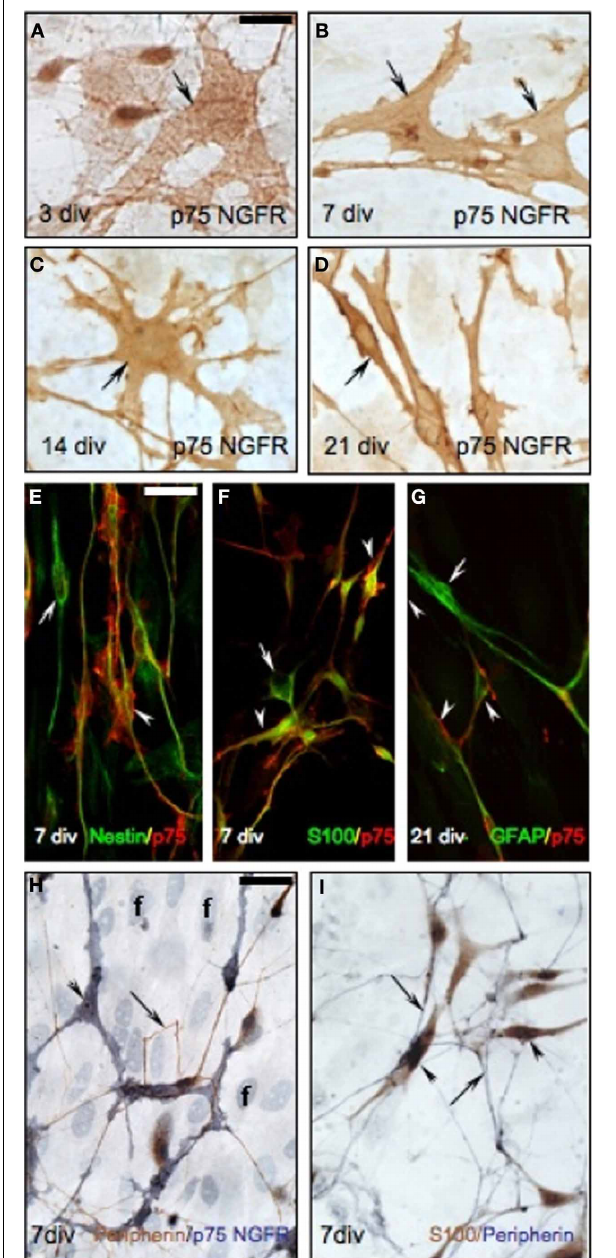
FIGURE 6 | Characterization of p75NGFR positive OECs in nasal explants. (A–D) p75NGFR-immunoreactive cells (brown, arrows) in the periphery of nasal explant undergo morphological changes, increasing process extensions between 3 (A) , 7 (B) , and 14 (C) div, and changing from multipolar to bipolar between 14 (C) and 21 (D) div. (E) Double-immunofluorescence using nestin (green) and p75NGFR (red) antibodies at 7div showed a subpopulation of p75NGFR-positive multipolar cells (arrowhead) coexpressed nestin, an early neural marker. Some nestin-positive/p75NGFR-negative cells were also evident (arrow). (F) Double-labelimmunofluorescence colocalizedS100(OECmarker,green)and p75NGFR(red)at7div(arrowheads).SomeS100-positive/p75NGFR-negative elements ( F ,arrow) were also detected in the periphery of the explant. (G)